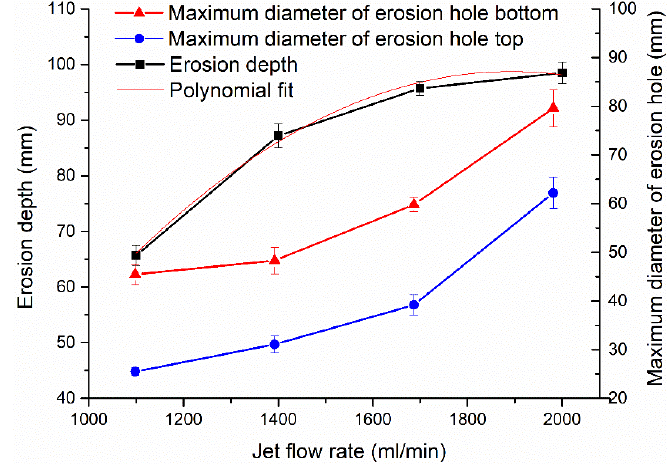
Figure 4. The influence of jet flow rate on the erosion depth, the maximum diameter of the erosion ‐ hole top, and the maximum diameter of the erosion ‐ hole bottom.